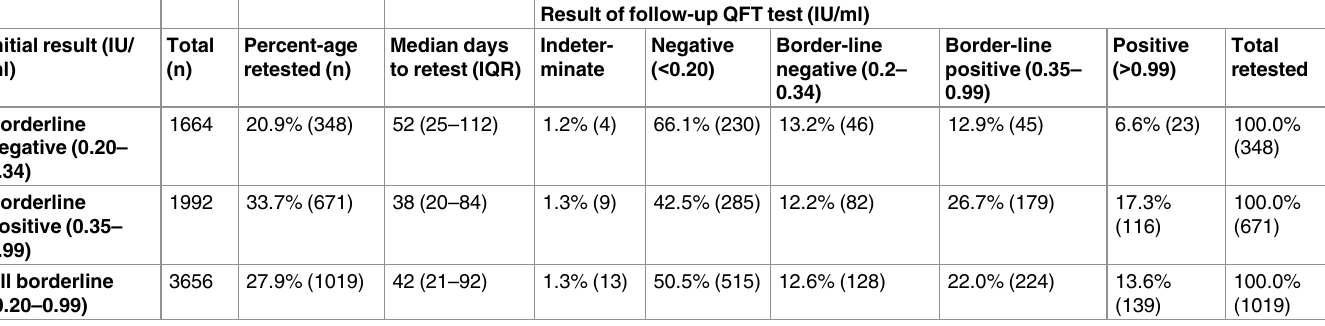
Table 1. Categorical distribution of follow-up QFT results when retesting those with initial result in the borderline range (0.20–0.99IU/ml). Result of follow-up QFT test (IU/ml)